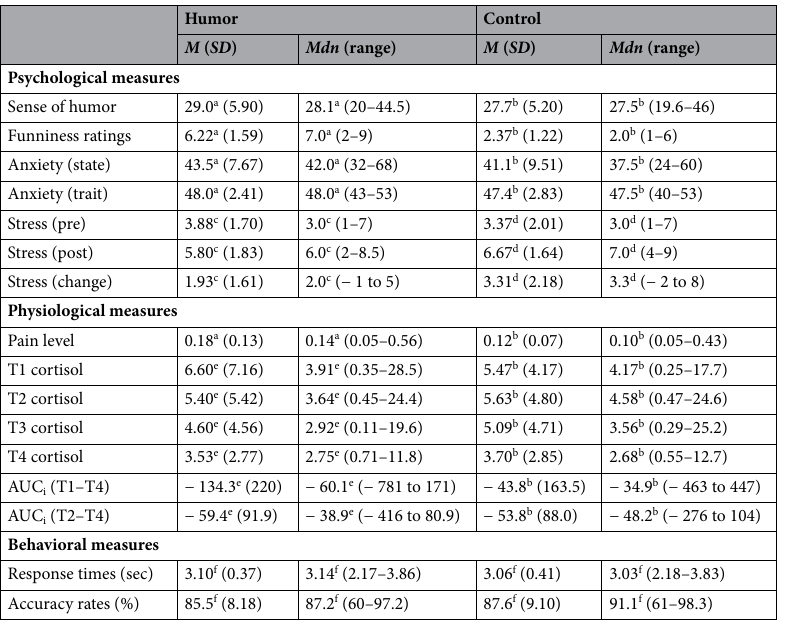
Table 1. Group characteristics including psychological and physiological measures as well as behavioral data for the humor and the control condition. M mean, SD standard deviation, Mdn median, T1–T4 time points 1–4, AUCi area under the curve with respect to increase. a n = 41. b n = 38. c n = 20. d n = 19. e n = 40. f n =